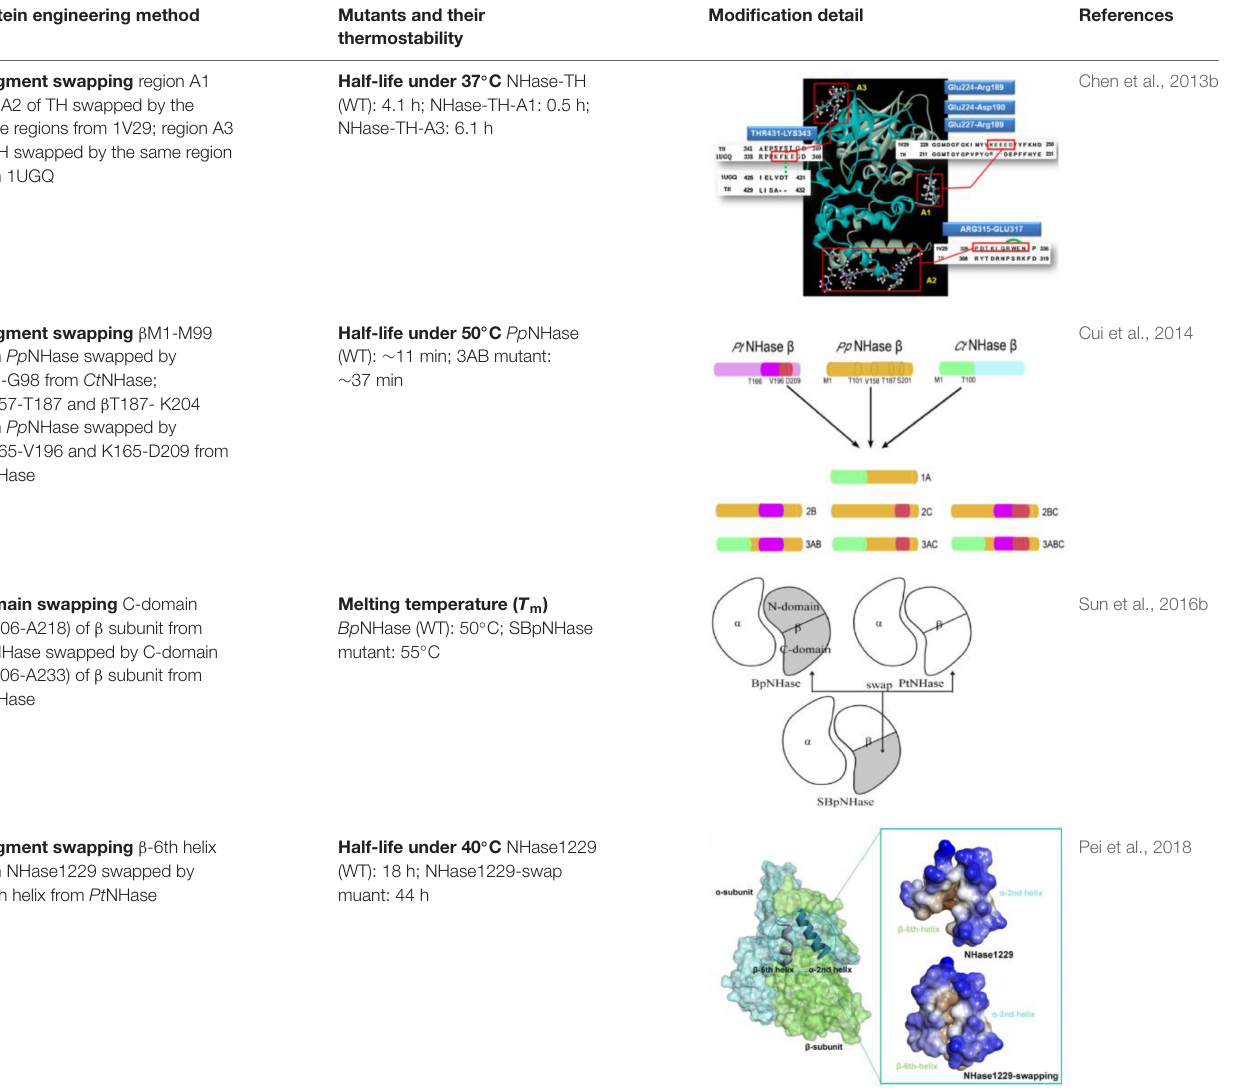
TABLE 3 | Summary of the advances in thermostability engineering of NHase in recent